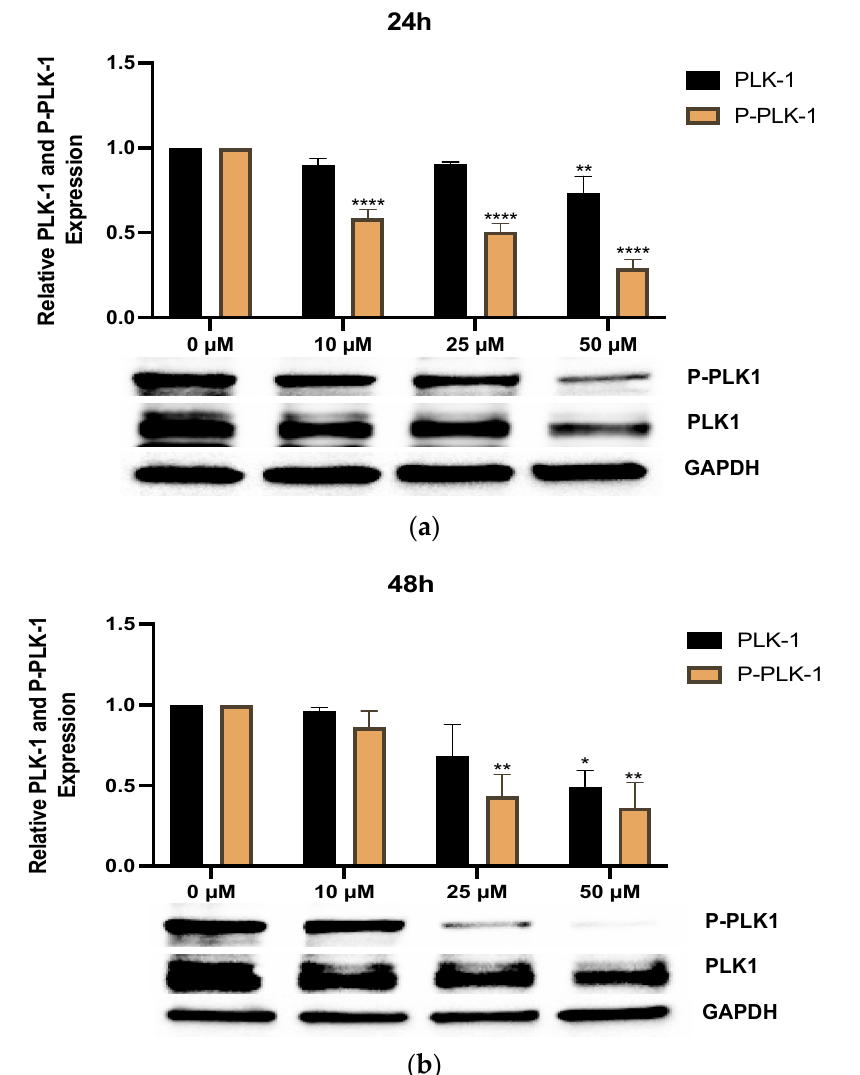
Figure 4. RK-10 decreases PLK1 expression. PLK1 and phosphorylated PLK1 protein expression was measured in MDA-MB 231 cells. Cells were treated with 0, 10, 25, and 50 µM of RK-10 for ( a ) 24 h and ( b ) 48 h and assayed by immunoblotting to examine the expression levels of PLK1, phosphorylated PLK1, and GAPDH (loading control). Student’s t -tests were performed and treatments were compared to the DMSO control. Results are expressed as the means ± SDs (**** p < 0.0001, ** p < 0.01, * p < 0.05), and data are representative, from one of at least three independent experiments.